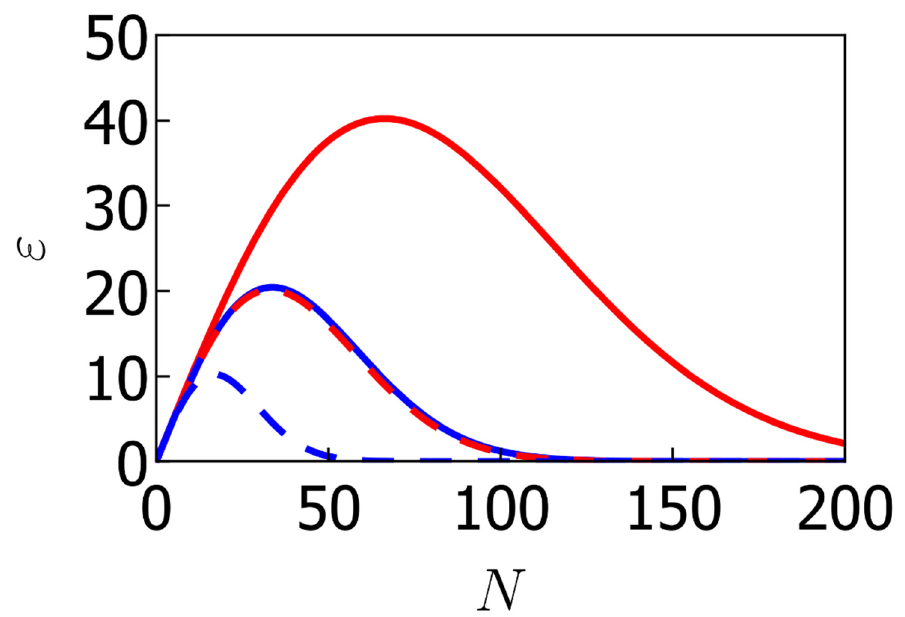
Figure 3. Improvement factor versus the momentum transfer with three different initial sizes of the atomic cloud. The final size of the atomic cloud is 1 cm. The temperature of the atoms is 6 µ K. The red curves are the plots for σ 0 = 0.1 mm while the blue curves are for σ 0 = 0.2 mm. The solid (dashed) curves correspond to an angular velocity of 1 (2) µ Hz.